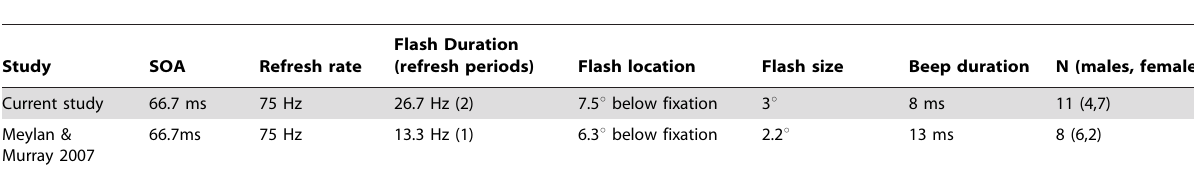
Table 2. Stimulus configuration differences between the current study and Meylan & Murray